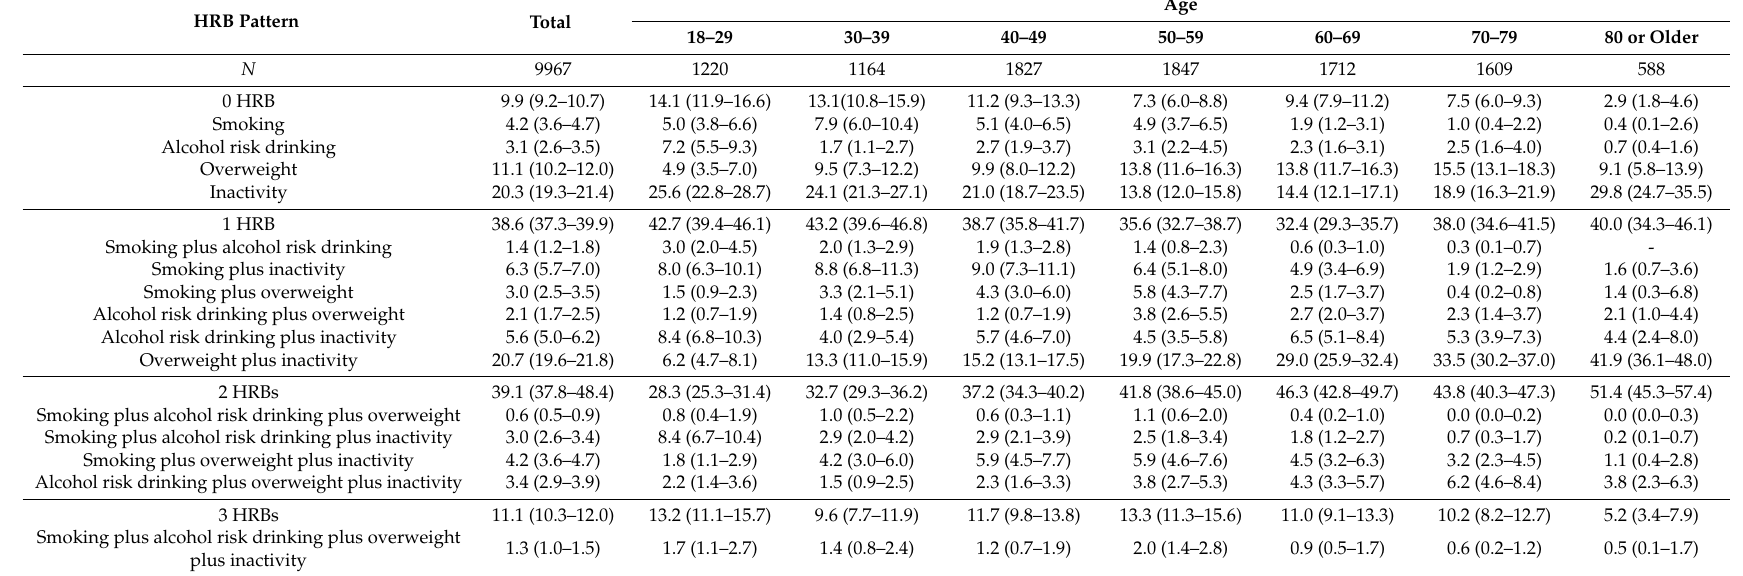
Table 1. Multi-behavior risk constellations females, % (95% confidence